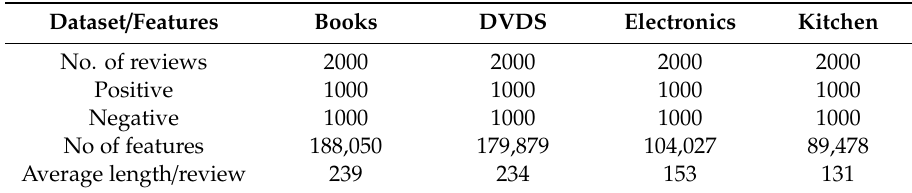
Table 1. Characteristics of The Data Set.